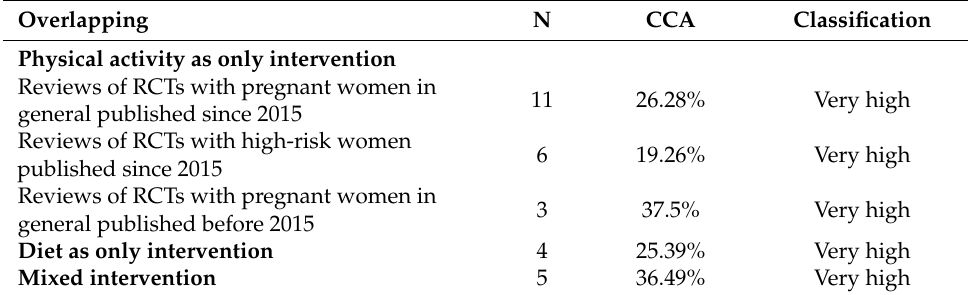
Table 1. Overlapping between